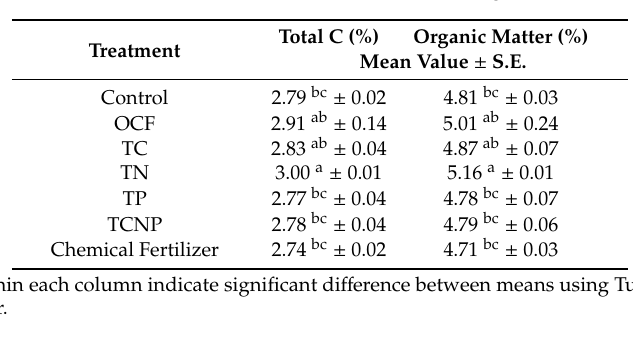
Table A4. E ff ect of treatments on soil total carbon and organic matter contents.